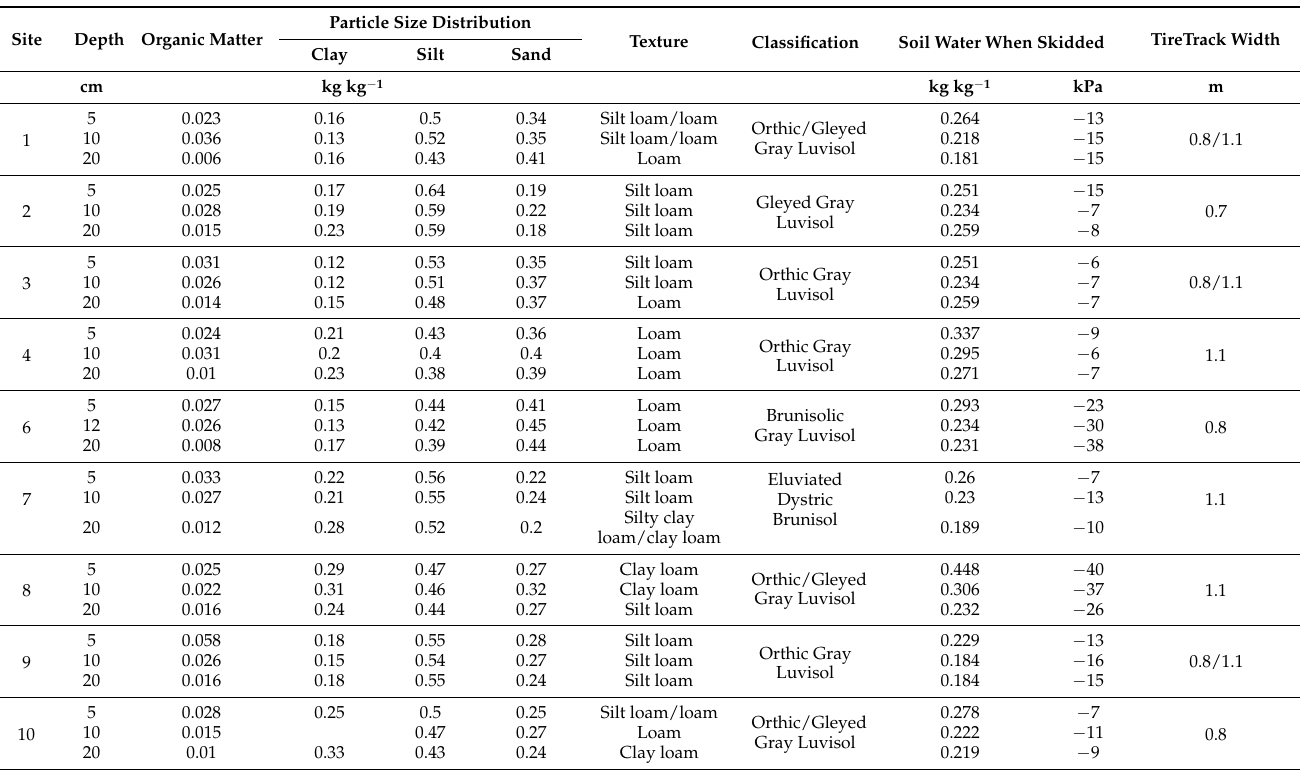
Figure 2. Illustration of location and location of each replication at each site. Table 1. Soil organic matter and particle size distribution ( n = 4), soil classification, and soil water content and tensiometer water potential ( n = 64) at the time of skidding